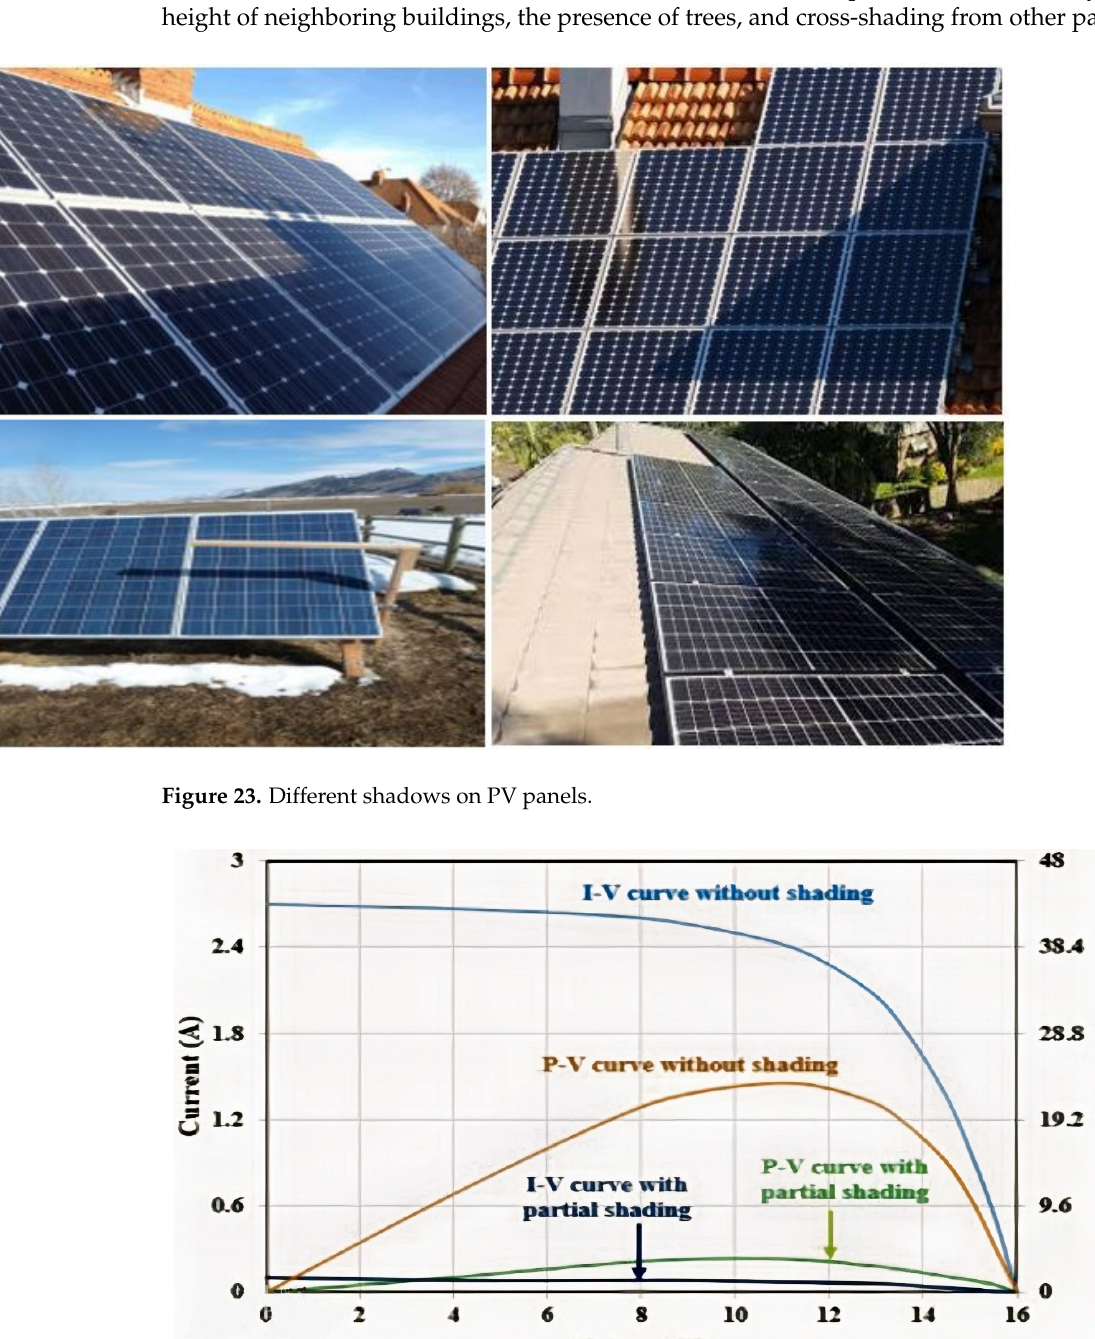
Figure 24. Measured characteristics of I-V, P-V curves for shaded and partially shaded panels [9].